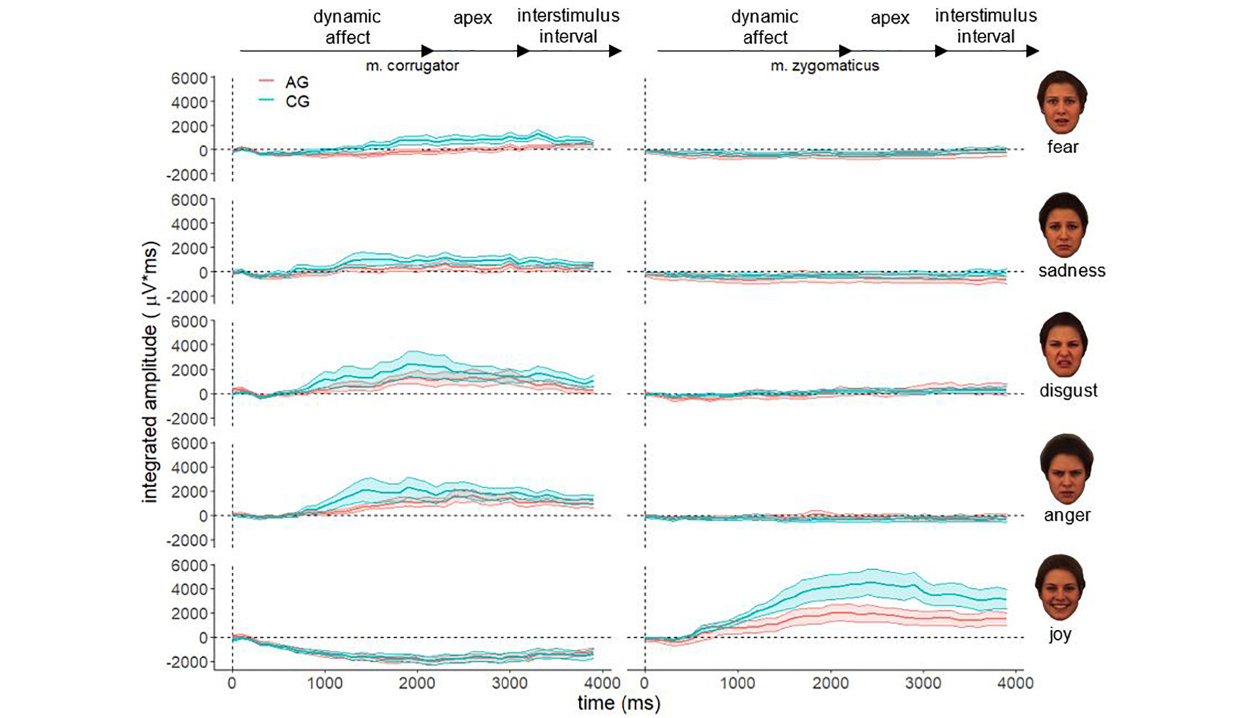
FIGURE 3 | Electromyographical activity [ µ V integrated over 40 × 100 ms interval ( µ V × ms)] of corrugator supercilii (m. corrugator) and zygomaticus major [m. zygomaticus) for AG (red line) and CG (blue line)] in response to video clips of affect expressing faces of adults for all basic affects. Measurement period 0–4000 ms, vertical dotted line represents stimulus onset; ribbons represent the standard